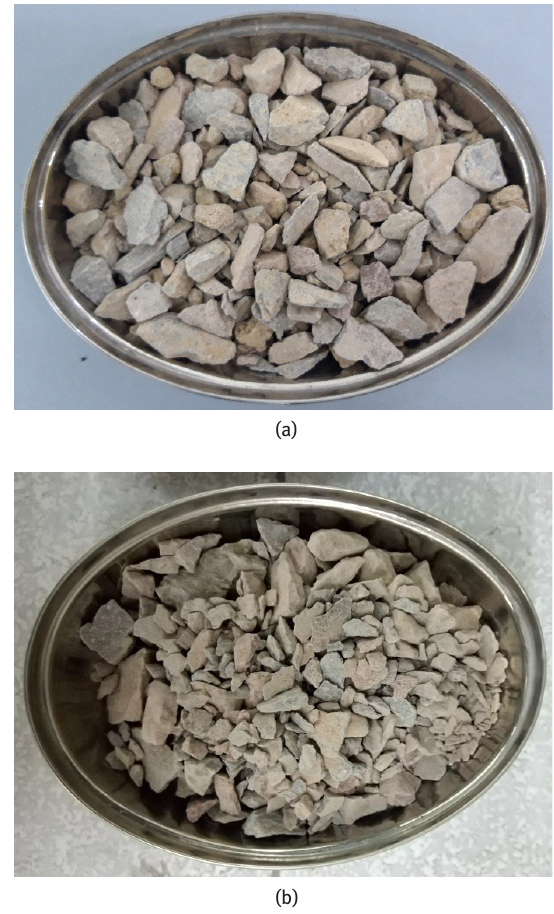
Figure 3: Sample before (a) and after (b) fragmentation